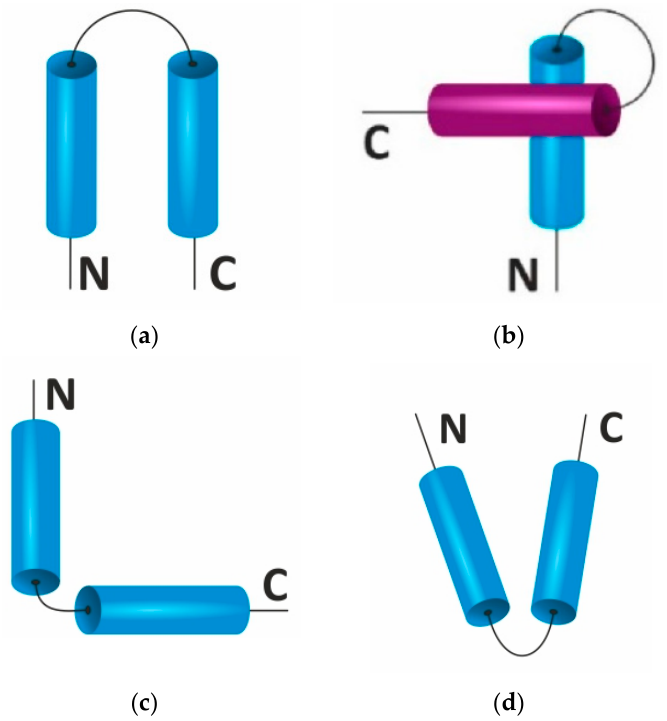
Figure 1. Types of helical pairs containing two α -helices, with a unique folding of the polypeptide chain in space. ( a ) α -helical hairpin, ( b ) α - α -corner, ( c ) L-shaped structure, and ( d ) V-shaped structure. Colors indicate α -helixes lying in different planes (layers).